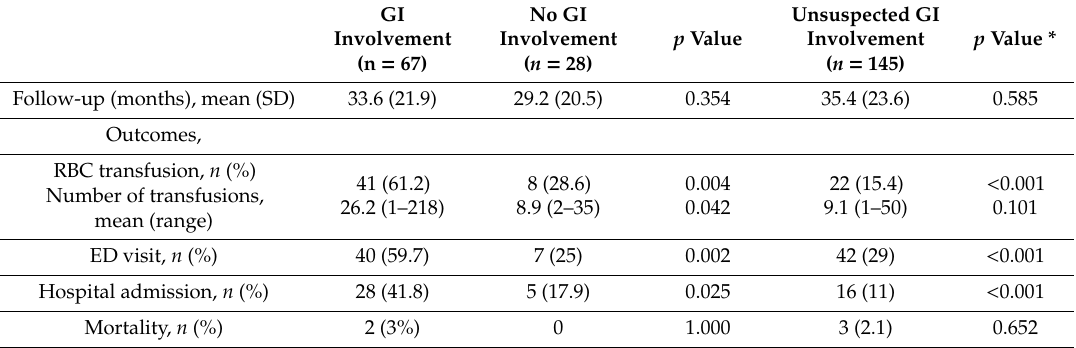
Table 4. Clinical outcomes during follow-up according to gastrointestinal